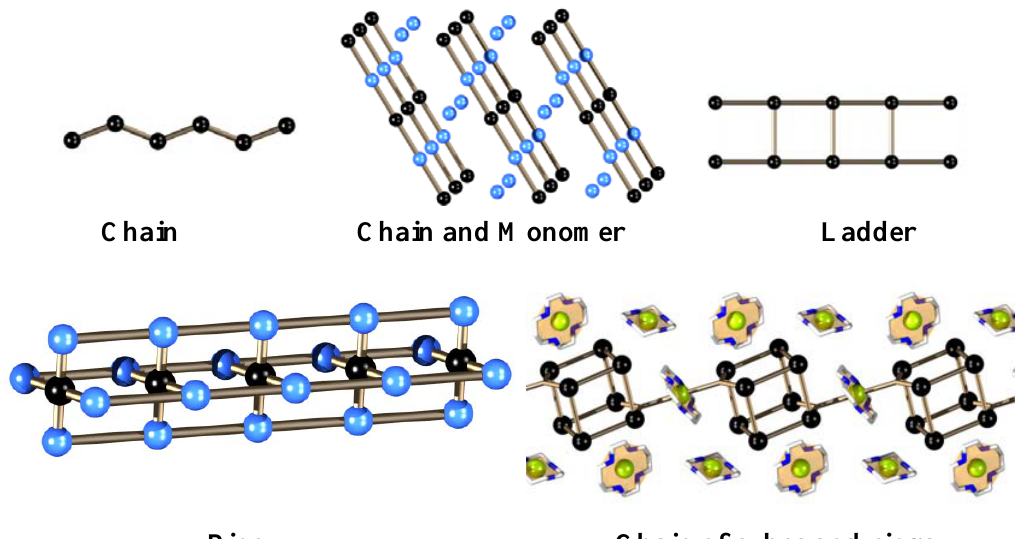
Figure 1. Topology of one-dimensional coordination polymers.